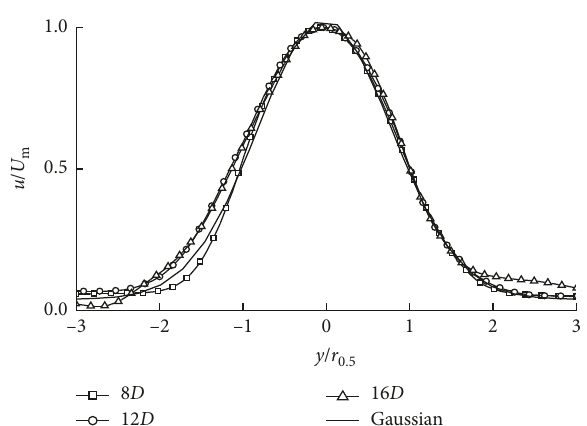
Figure 4: Self-preservation profiles of the mean streamwise ve- locity by the LES method.